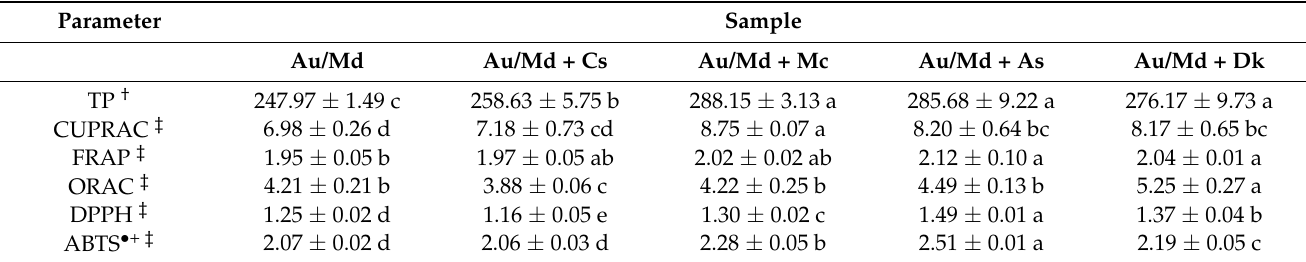
Table 1. Antioxidant activity of analysed apple-strawberry tree fruit smoothies. Parameter